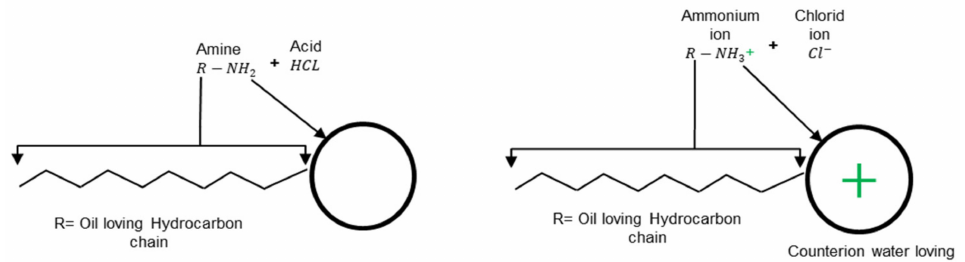
Figure 2. Example of a cationic soap production adapted from